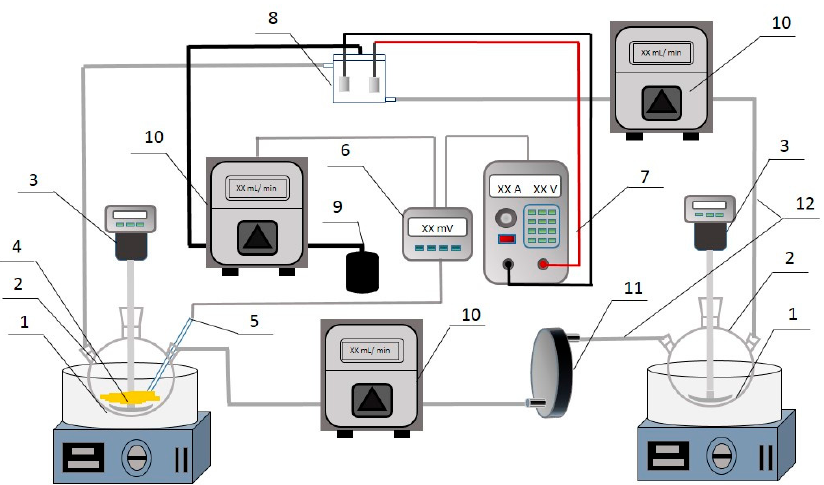
Figure 1. Apparatus for pyrite leaching under controlled redox potentials. (1—constant temperature bath; 2—round-bottom flask; 3—over head stirrer; 4—pyrite sample; 5—ORP probe; 6—ORP controller; 7—DC power system; 8—electrolysis cell; 9—H 2 O 2 solution; 10—peristaltic pump; 11—filter plate; 12—silicone tube).